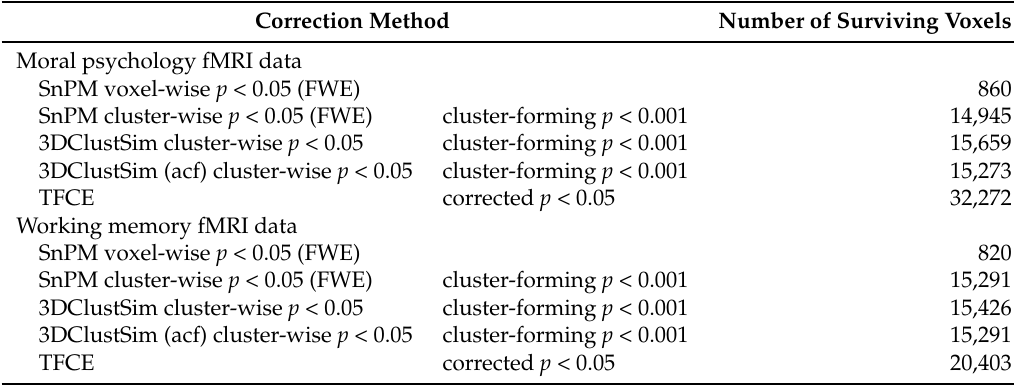
Table 1. Surviving voxel number for each correction method.